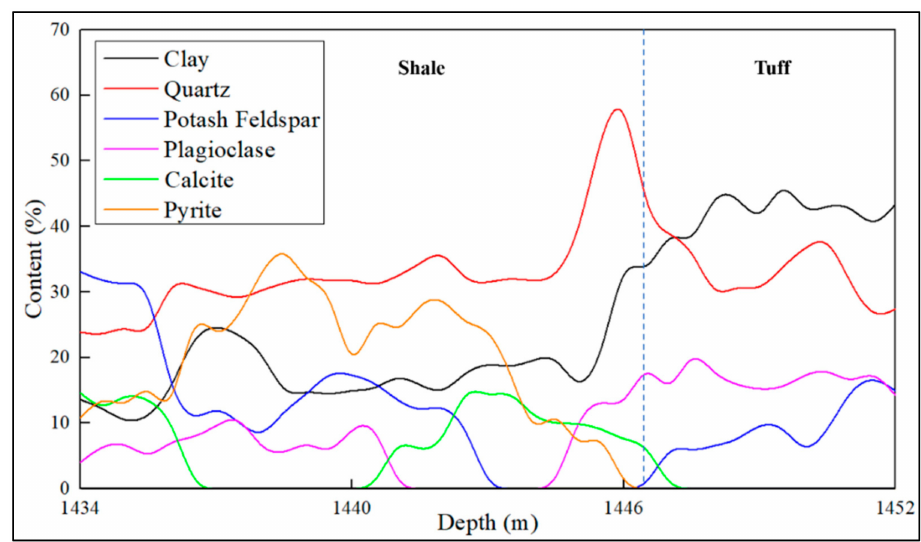
Figure 9. B1 well mineral composition curve with depth.